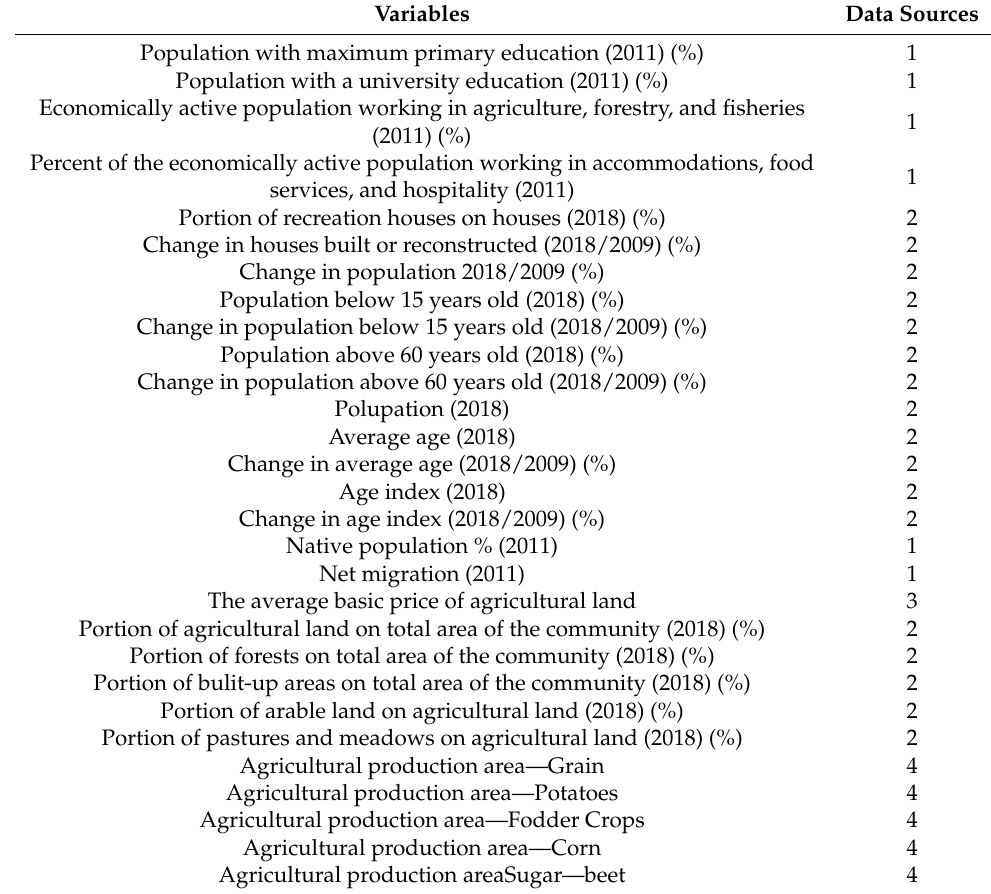
Table A1. Characteristics of communities used in regression